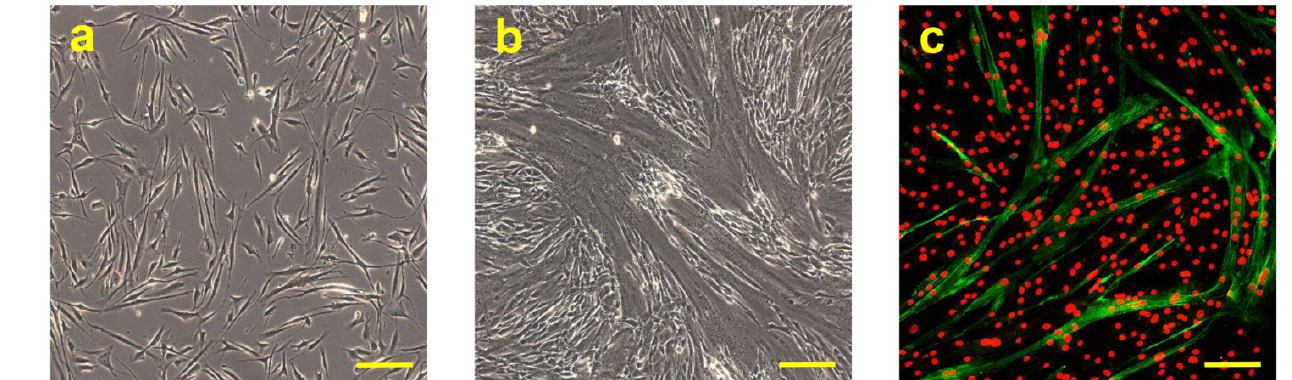
Figure 1. Representative observation of primary culture of hSCs in phase-contrast microscopy, objective 10 × , scale bar 200 µ m ( a ); representative observation in phase-contrast microscopy of the multinucleate cells after 6 days of myogenic induction, objective 10 × , scale bar 200 µ m ( b ). Representative fluorescence observation of MHC protein produced by hSCs after 6 days in myogenic induction. MHC, present in myotubes, is stained green (Alexa Fluor 488) and nuclei are stained red (ethidium bromide), objective 10 × , scale bar 200 µ m ( c ).